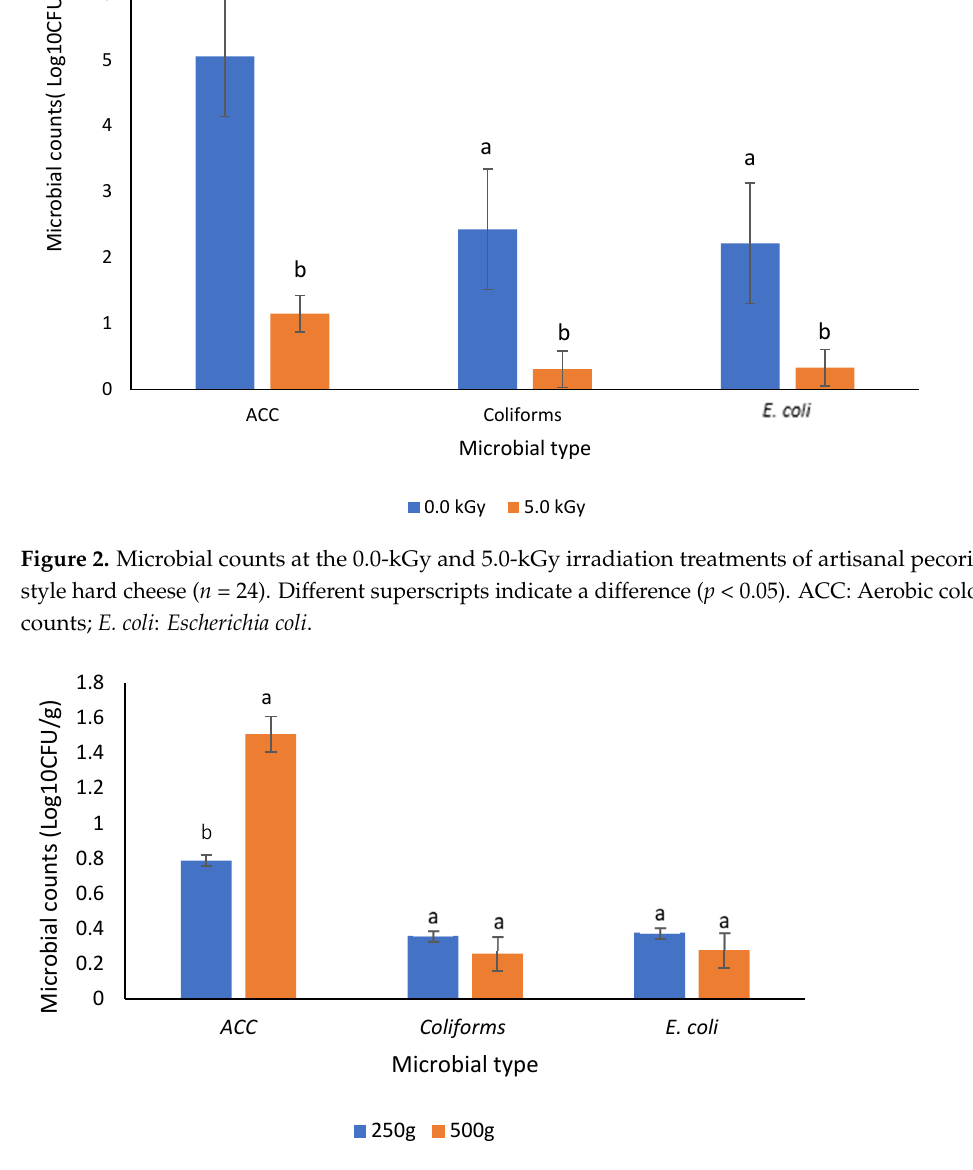
Figure 3. Microbial counts of artisanal pecorino-style cheese of pieces of 250 and 500 g at the 5.0-kGy irradiation treatment ( n = 24). ACC: Aerobic colony counts; E. coli : Escherichia coli .